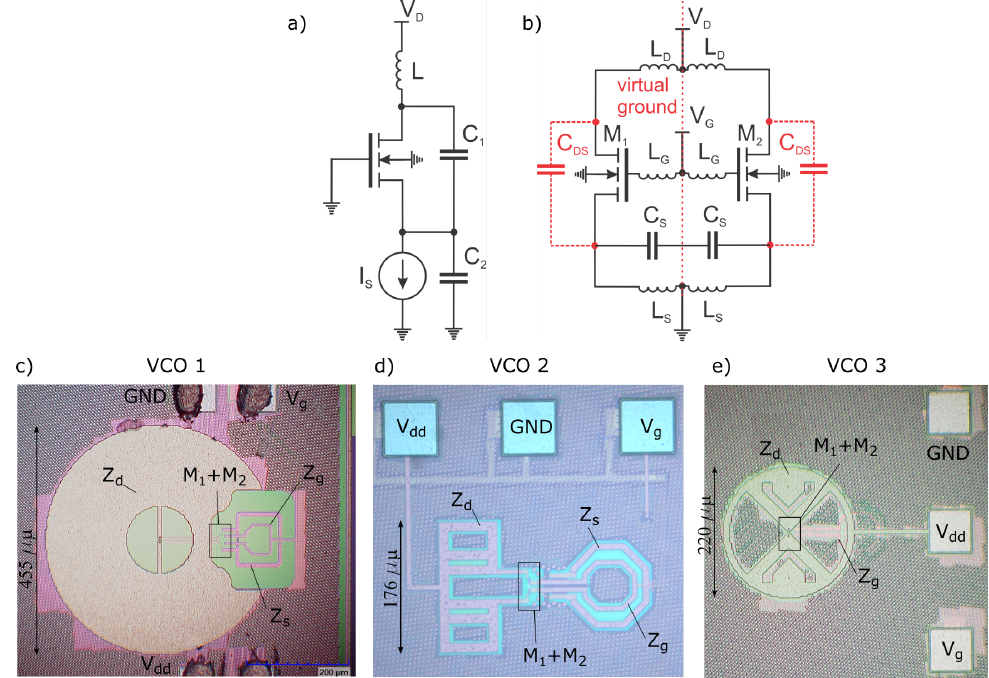
Figure 4. ( a ) The schematic of the basic concept of Colpitts oscillator. ( b ) The proposed VCO is based on the differential configuration of the Colpitts oscillator. Die micrographs of the first VCO (( c ), area of core 465 µm × 455 µm), the second VCO (( d ), 284 µm × 176 µm) and the third VCO (( e ), 305 µm × 220